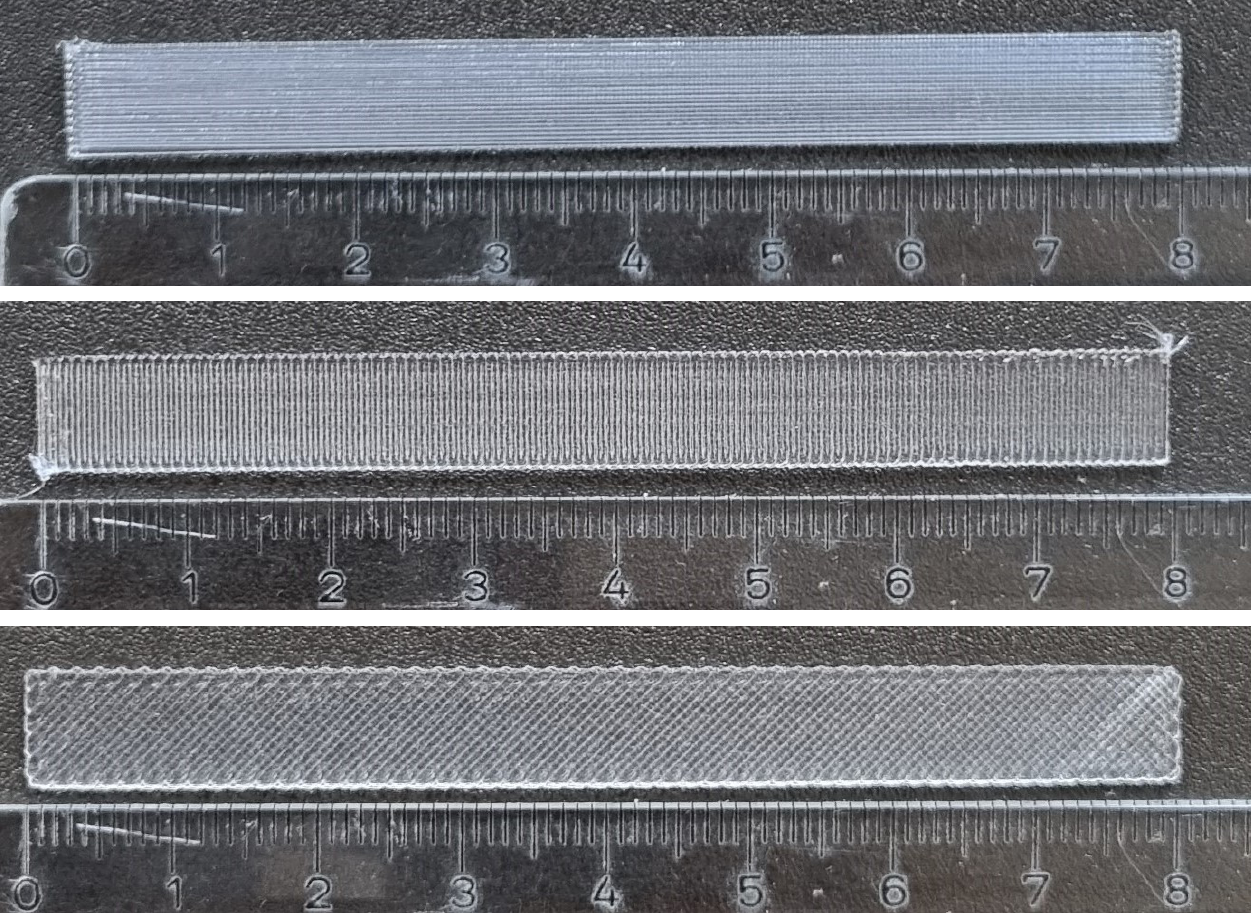
Figure 18. The 3D printed 0°, 90° and − 45°/45° orientated specimens of the type B